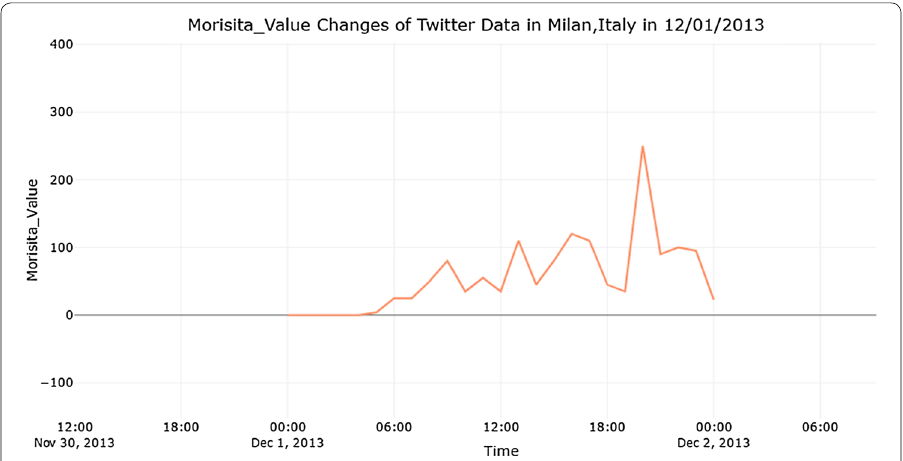
Fig. 16 Line chart of Morisita value of twitter data in Milan, Italy in